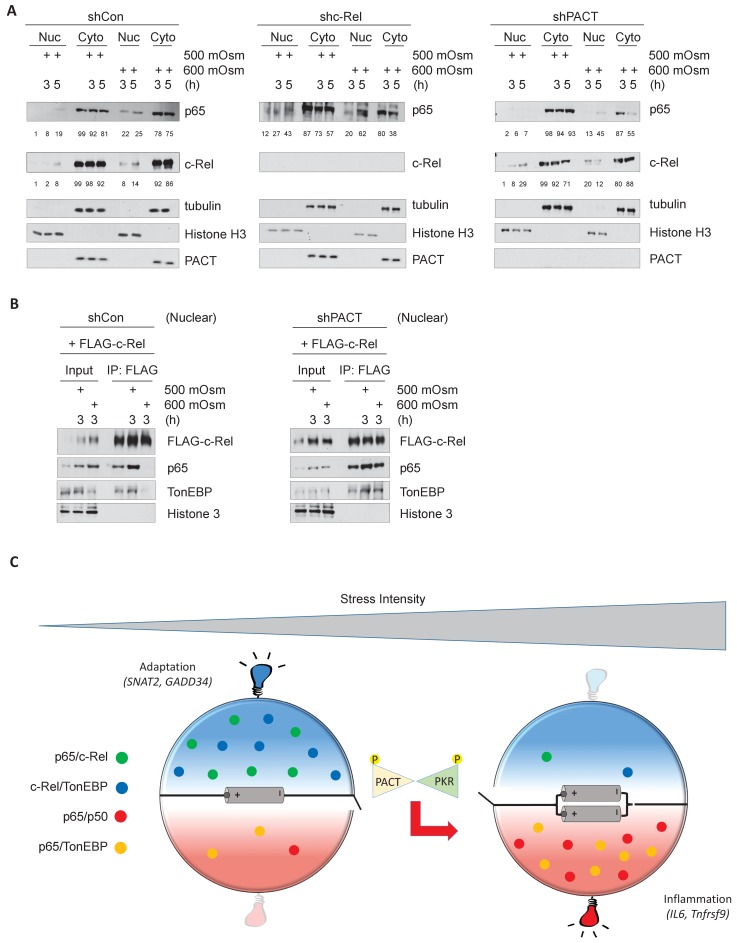
Hyperosmotic stress causes nuclear translocation of a small subset of NF-κB proteins.(A) Control, shc-Rel, and shPACT MEFs were treated with the indicated intensities and durations of hyperosmotic stress, then cells were fractionated into cytoplasmic and nuclear lysates. Equal volumes of protein were analyzed via western blot. Protein localization was quantified as percentages in the corresponding nuclear or cytoplasmic fractions by densitometric analysis. (B) Control and shPACT MEFs were transfected with FLAG-NF-κB c-Rel. Cells were fractionated into nuclear and cytoplasmic lysates, and FLAG-NF-κB c-Rel was immunoprecipitated from nuclear lysates. Nuclear extracts and coimmunoprecipitated proteins were analyzed via western blot. (C) Adaptation to increased osmolarity of the extracellular environment involves Rel family transcription factors TonEBP and c-Rel. At high stress intensities, cells fail to adapt and proinflammatory signaling is induced via remodeling of Rel family transcription factor dimer formation. Loss of adaptation to hyperosmotic stress associates with increased TonEBP/p65 dimerization and loss of TonEBP/c-Rel and p65/c-Rel dimerization. PACT-mediated PKR activation marks the loss of adaptation and enhancement of proinflammatory gene expression.